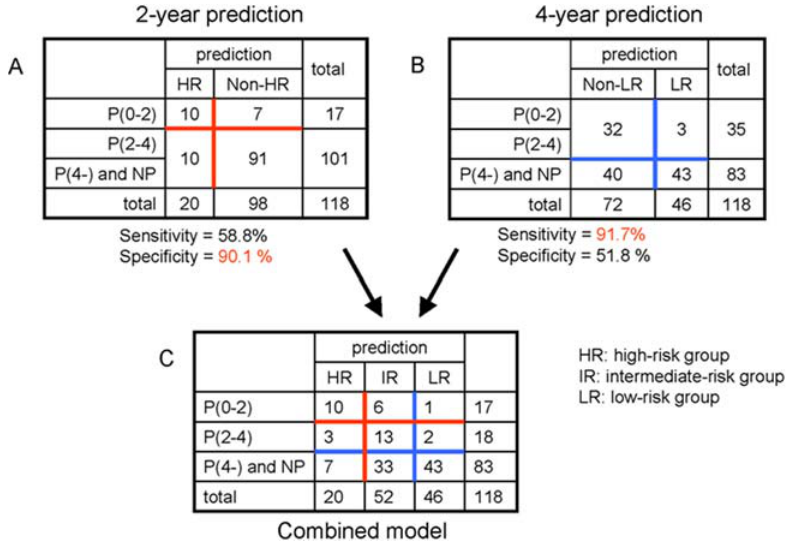
Figure 4. Combining the 2-year and 4-year prediction models. A and B: 2 6 2 contingency tables for the 2-year and 4-year prediction models, respectively. Cutoff points for the 2-year and 4-year model output values were chosen to attain 90% specificity and sensitivity, respectively, as described above ( Figure 3) . C: combined 3 6 3 contingency table. Red and blue cross-lines correspond to red and blue lines in A and B . P(0-2), P(2-4), P(4-): specimens obtained from progressor patients , =2 years, 2–4 years, or . 4 years prior to progression, respectively. NP: specimens derived from